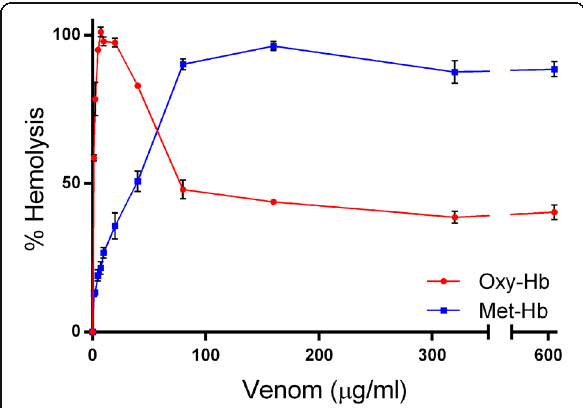
Fig. 1 Hemolytic effect of CMNv. Erythrocytes were treated with different concentrations of CMNv (0 – 640 μ g/mL) for 24 h. Oxy-Hb is represented by a red line and Met-Hb by a blue line. Data are represented as the mean of three independent experiments with its respective standard